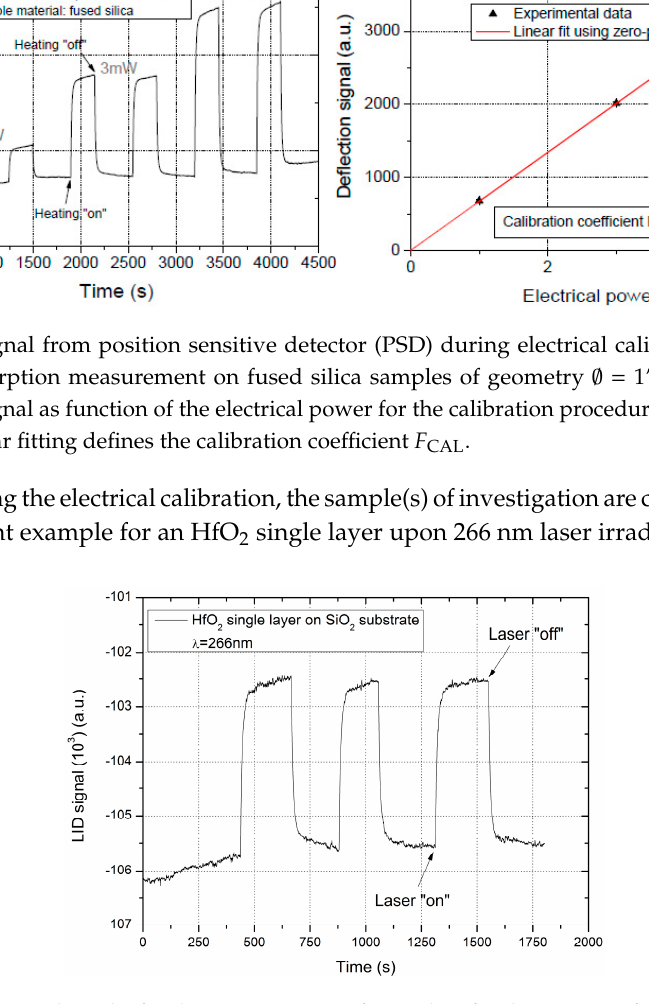
Figure 3. ( a ) Signal from position sensitive detector (PSD) during electrical calibration procedure for surface absorption measurement on fused silica samples of geometry ∅ = 1”, thickness 1mm. ( b ) Deflection signal as function of the electrical power for the calibration procedure in Figure 3a. The slope of the linear fitting defines the calibration coefficient F CAL .